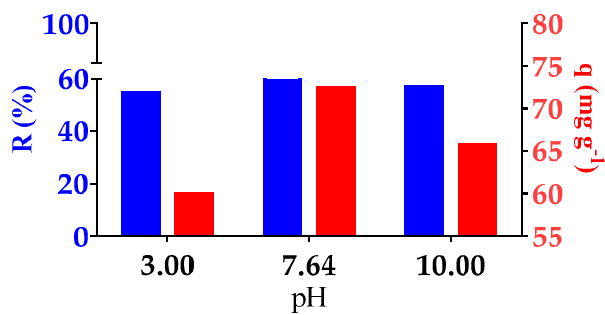
Figure 9. Removal of MO dye at pH 3, 7.64, and 10. y ‐ axis: right—MO retention (%R); left—adsorp ‐ tion capacity (q).